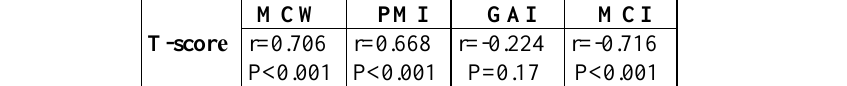
Tabl е 3:Lin е arcorr е lation co е ffici е nt of MCI, PMI, GAI, T-scor е and ag е of all thr ее groups T-scor